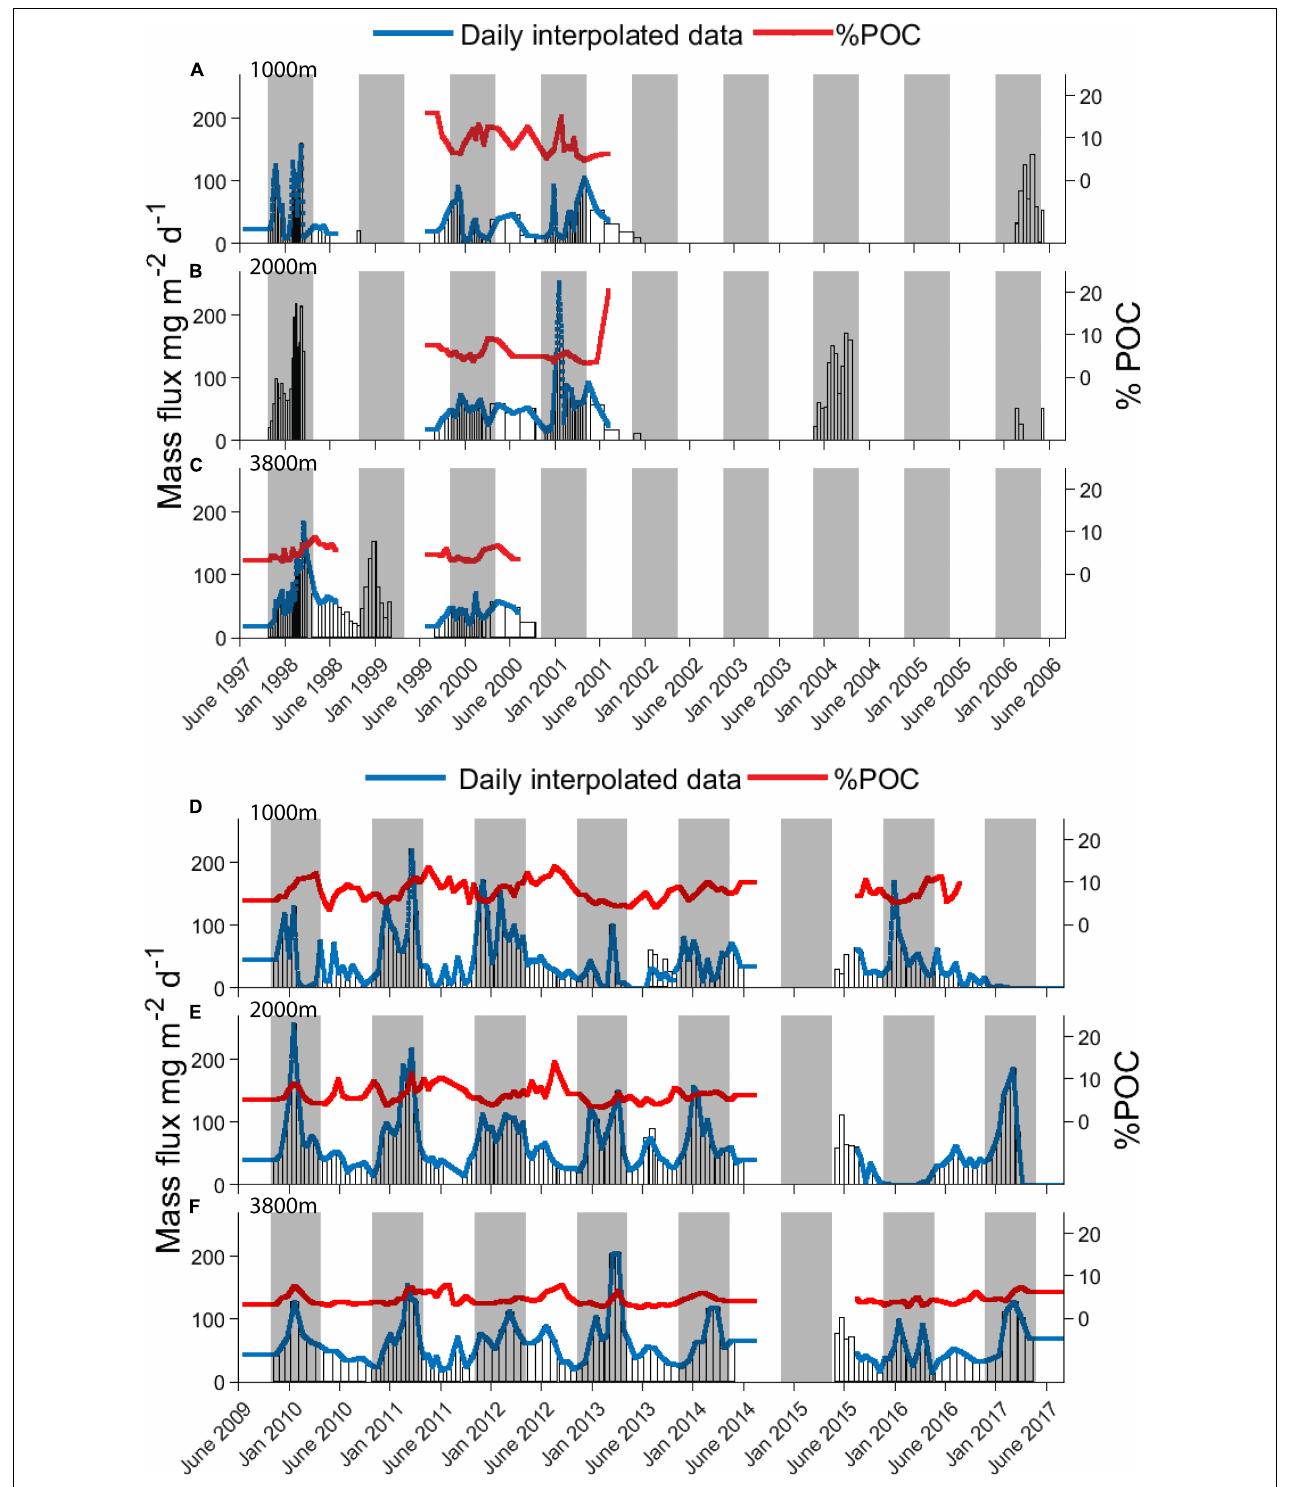
FIGURE 3 | Multi-year record of mass fluxes at SOTS showing interannual variability in timing and amplitude of peak mass flux periods. Collection cup durations are represented by bar widths, with interpolated daily fluxes overlaid in blue and % POC (w/w) compositions in red. (A–C) Are for the first decade (June 1997 – June 2008) and (D–F) for the second decade (June 2008 to June 2017). Gray shaded areas represent the 6 months that cover the main flux period during early spring and summer, 21th September to 21th March, as shown by average fluxes discussed in section “Possible Role of Seasonality in Control of Flux: Mean Seasonal Cycles” and Figure 7